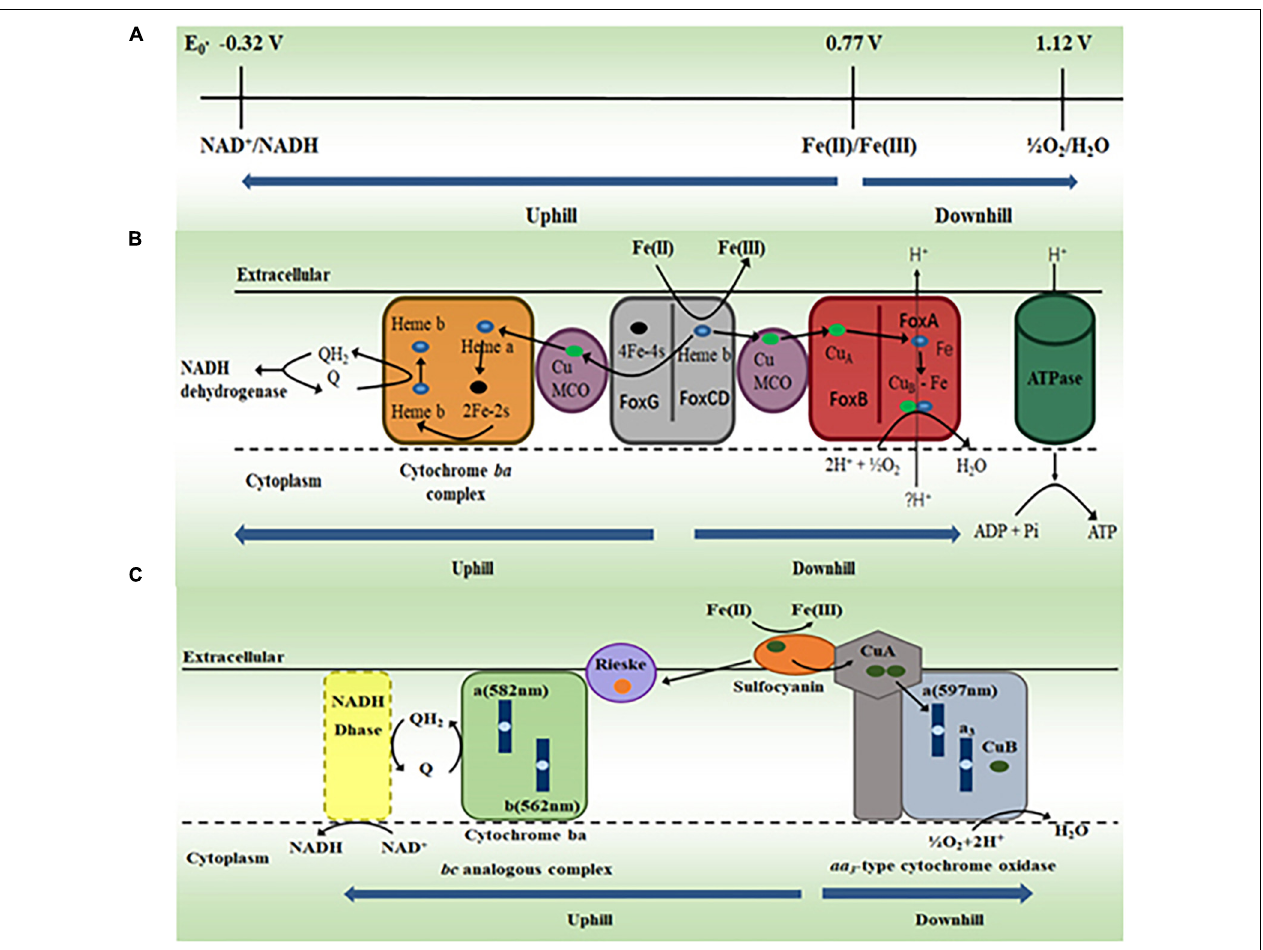
FIGURE 3 | The proposed molecular mechanisms for oxidizing Fe(II) by acidophilic archaea. (A) Standard redox potentials ( E 0 (cid:48) ) of NAD + /NADH couple at pH 6.5, Fe(II)/Fe(III) and O 2 /H 2 O couples at pH 2. Modified with permission from Bonnefoy and Holmes (2012) © (2012) Society for Applied Microbiology and John Wiley and Sons Ltd. (B) The proposed electron transfer pathway for oxidation of Fe(II) by Metallosphaera yellowstonensis . MCO, multicopper oxidase. Modified with permission from Kozubal et al. (2011) © (2011) American Society for Microbiology. (C) The proposed electron transfer pathway for oxidation of Fe(II) by Ferroplasma acidiphilum. Q, quinone; QH 2 , quinol. Modified with permission from Castelle et al. (2015) © (2015)